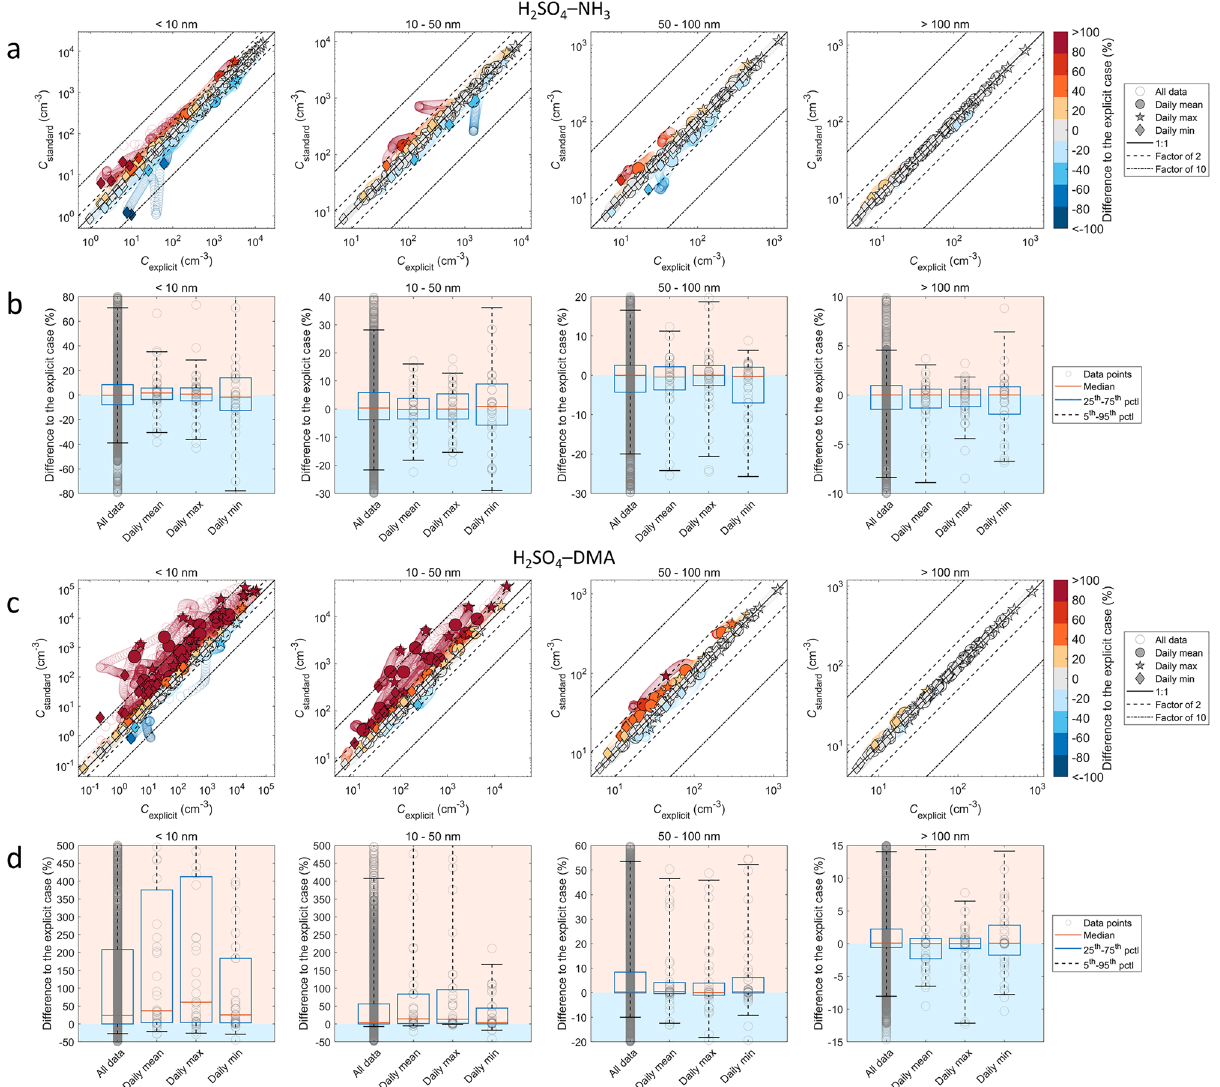
Figure 4. Size-classified particle number concentrations for the standard and explicit cases for all trajectories with initial particle formation from H 2 SO 4 –NH 3 ( a,b ), and H 2 SO 4 –DMA ( c,d ). ( a,c) show the absolute concentrations, and the color scale gives the difference Δ C = ( C standard − C explicit ) / C explicit between the standard and explicit cases. ( b,d) show statistics for the difference Δ C , with the corresponding data points Δ C shown in light grey. In ( b,d) , regimes of under- and overprediction are depicted by light blue and light red shades, respectively. Scales of y-axes are limited to ranges covering the 5th–95th percentiles of Δ C , except for the smallest sizes in ( b) for which the 95th percentiles extend to up to ca. 190% for < 10 nm (corresponding to ca. threefold overprediction), and ( d) for which the extent is up to ca. 5000% for < 10 nm (ca. 50-fold overprediction) and up to ca. 1000% for 10–50 nm (ca. tenfold